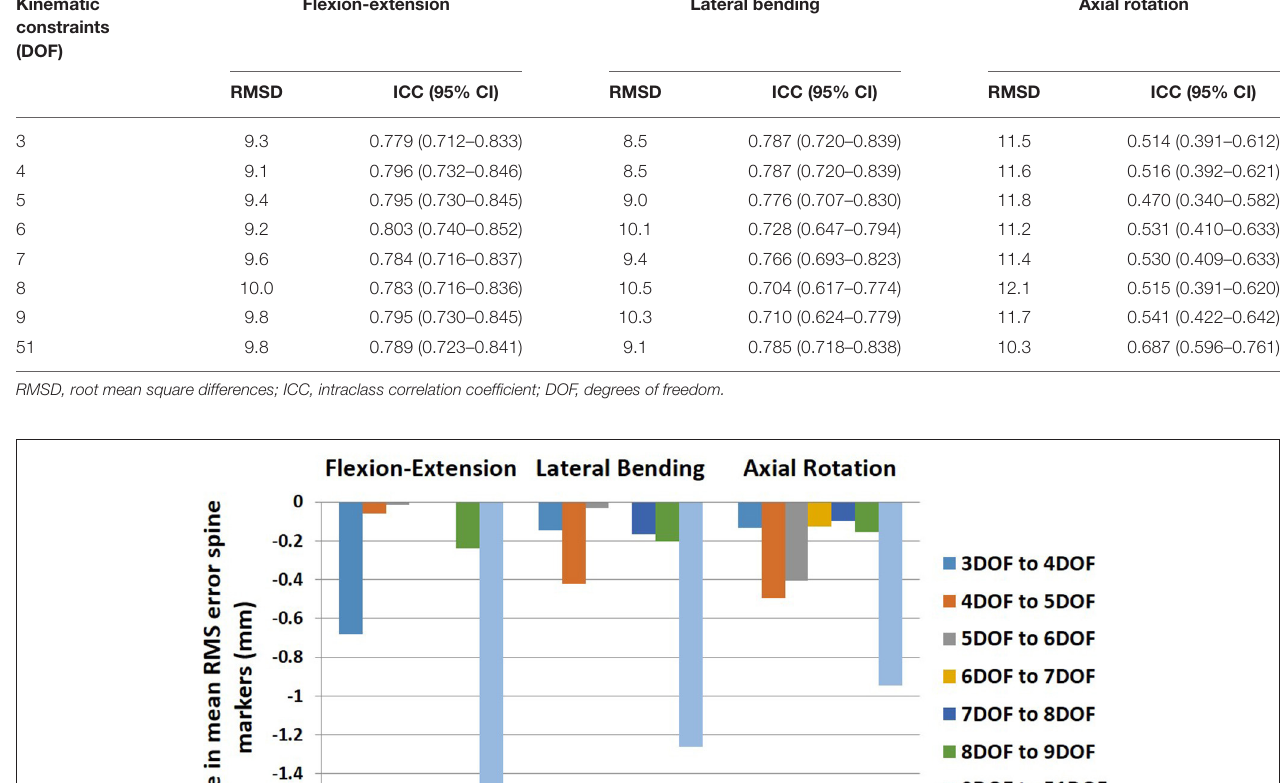
TABLE 6 | RMSD and ICCs for segmental spine angles from models with various spine DOFs vs. segmental angles calculated directly from the corresponding marker clusters. Kinematic constraints